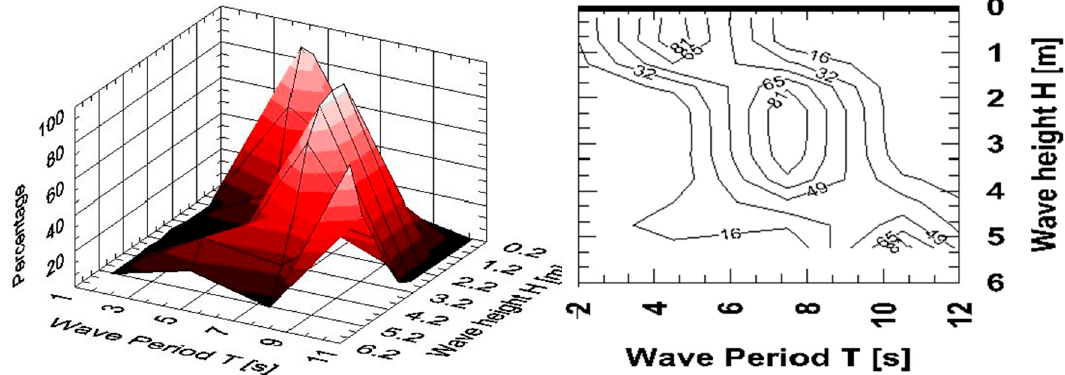
Figure 5. Joint distribution ( H s - T p ) for the angular sector 0–22.5 ◦ N. Left panel: 3D distribution. Right panel: contour lines.